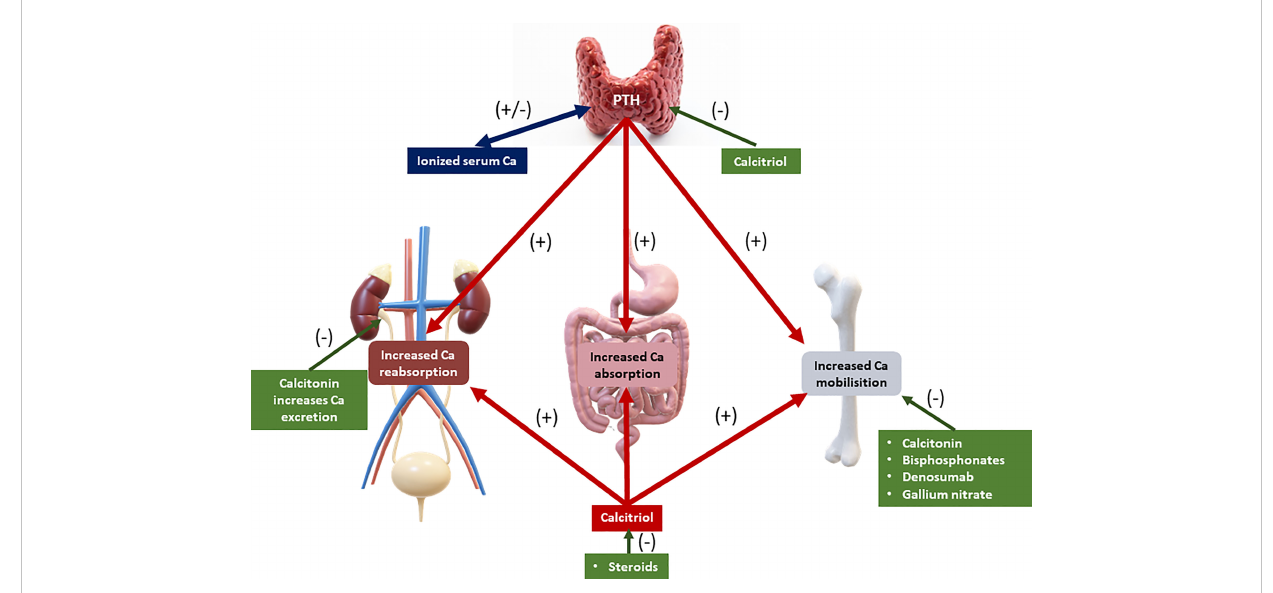
FIGURE 1 Calcium metabolism. PTH: parathyroid hormone. Green, decreasing effect on serum calcium level. Red: increasing effect on serum calcium